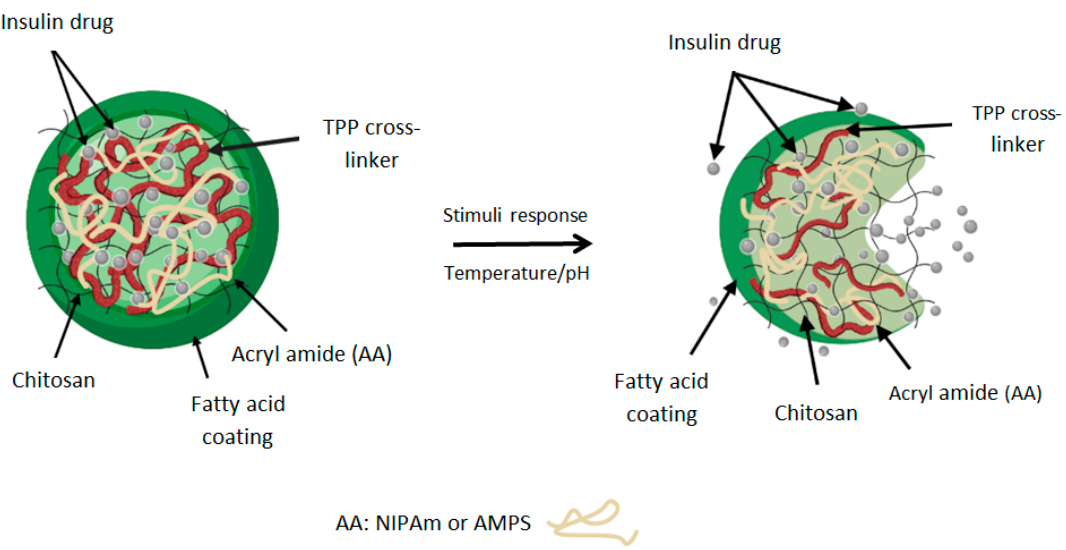
Scheme 1. Schematic representation of the insulin release mechanism from the CS ‐ amide ‐